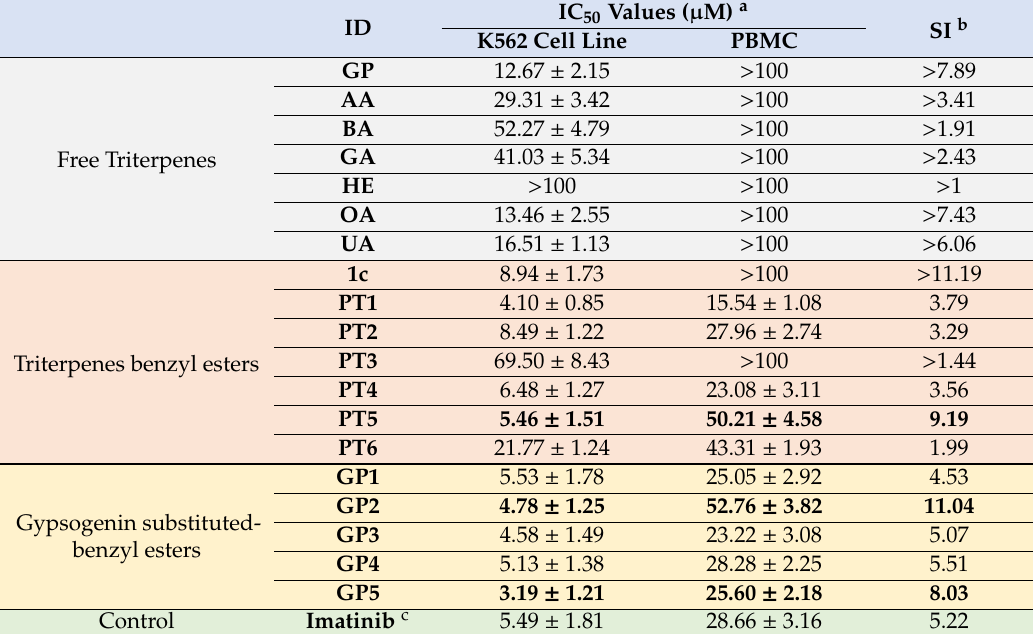
Table 1. The cytotoxic effects of all compounds on K562 and peripheral blood mononuclear cells (PBMC).